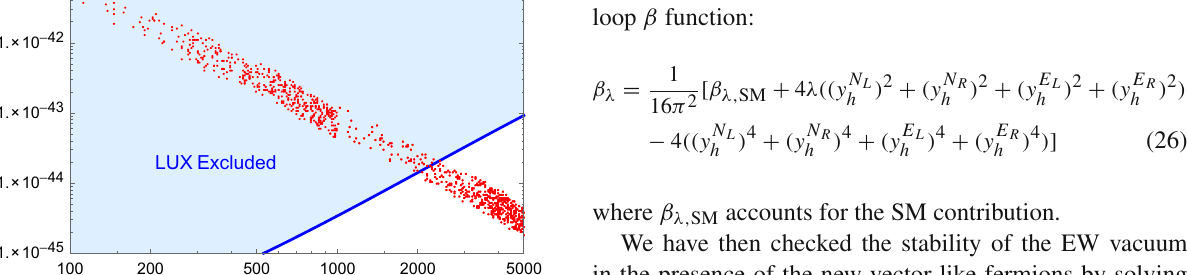
,σ SI ) . The blue region p 1